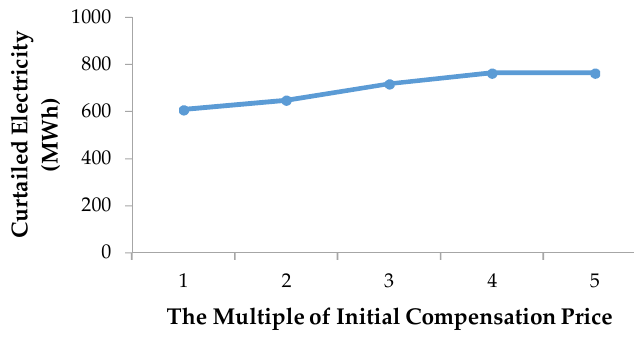
Figure 6. The revenues of both sides under different agreement prices.